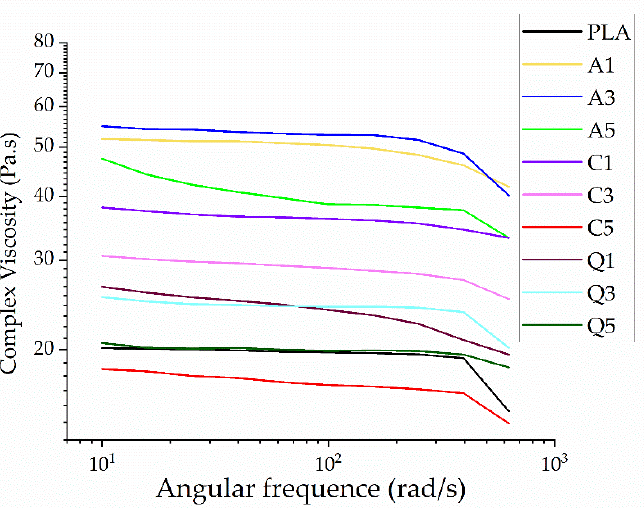
Figure 14. Rheogram of melt-electrospun fibers formed of PLA and its composites containing 1%, 3%, or 5% ( w / w ) of alizarin (A1, A3, A5), curcumin (C1, C3, C5), or quercetin (Q1, Q3, Q5).